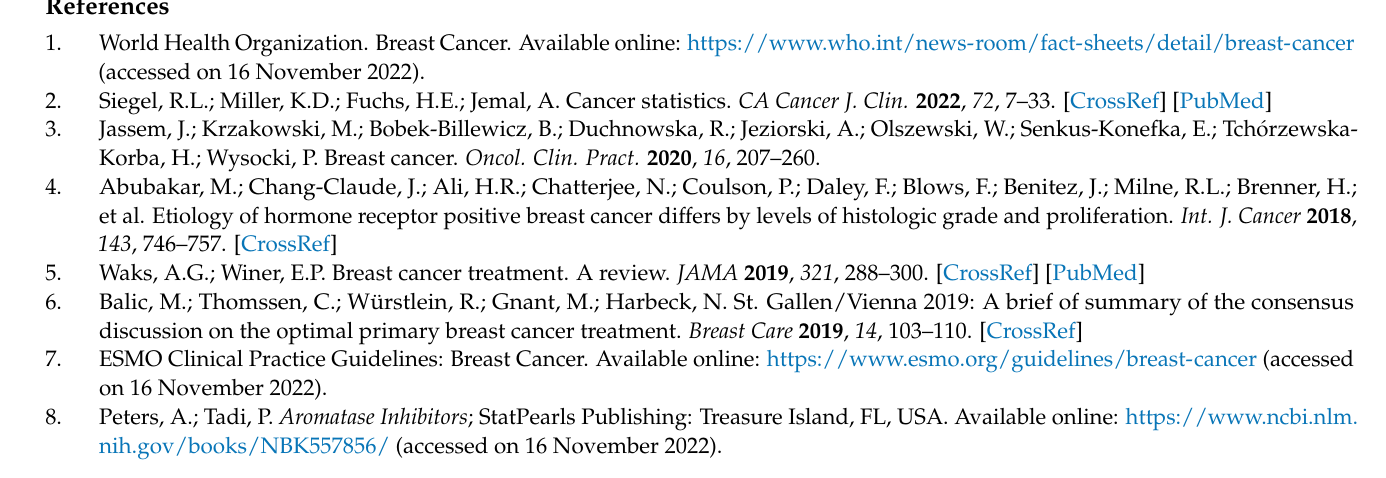
metalloestrogens and aromatase inhibitors on MCF-7/DOX cell viability. Figure S3: Gating strategy for flow cytometry analysis of apoptosis and necrosis assay. Figure S4: Representative cytogram for MCF-7 cell control. Figure S5: Representative cytogram for MCF-7/DOX cell